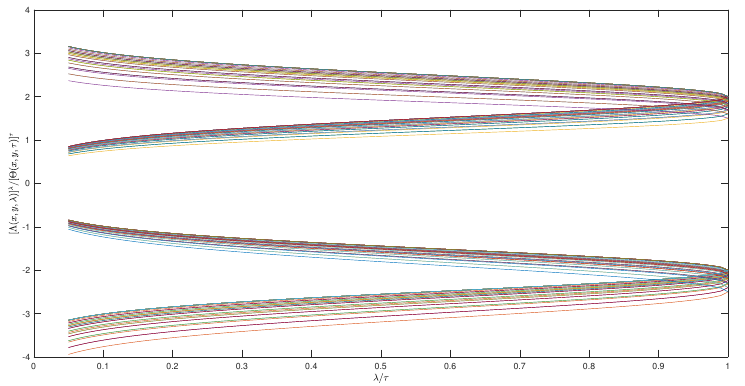
Figure 2. Numerical simulation for level sets of fuzzy solutions of (26) with the Gaussian fuzzy